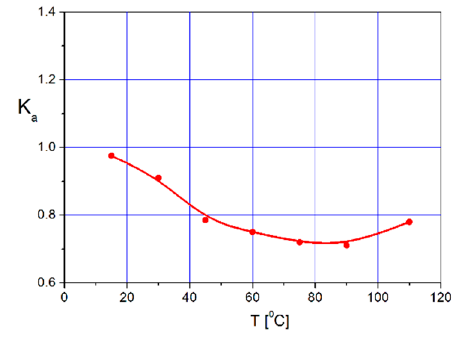
Figure 10. The effect of temperature on K a values for PTK 52 kV bushing [16].